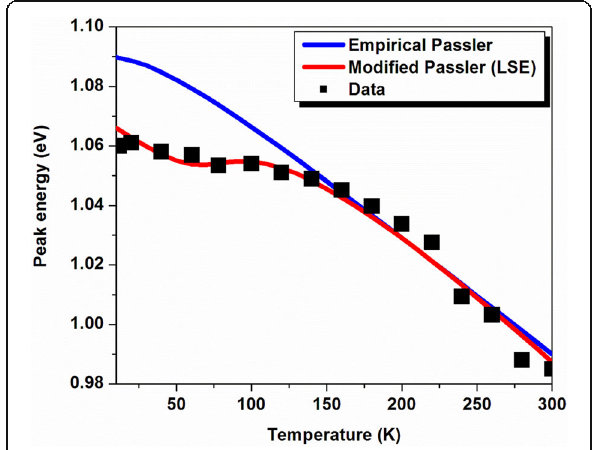
Fig. 9 Temperature-dependent photoluminescence evolution of the LQD peak ( solid black squares ) fitted using the empirical Passler law ( blue solid line ) and the modified Passler relation truth to the LSE model ( red solid line )